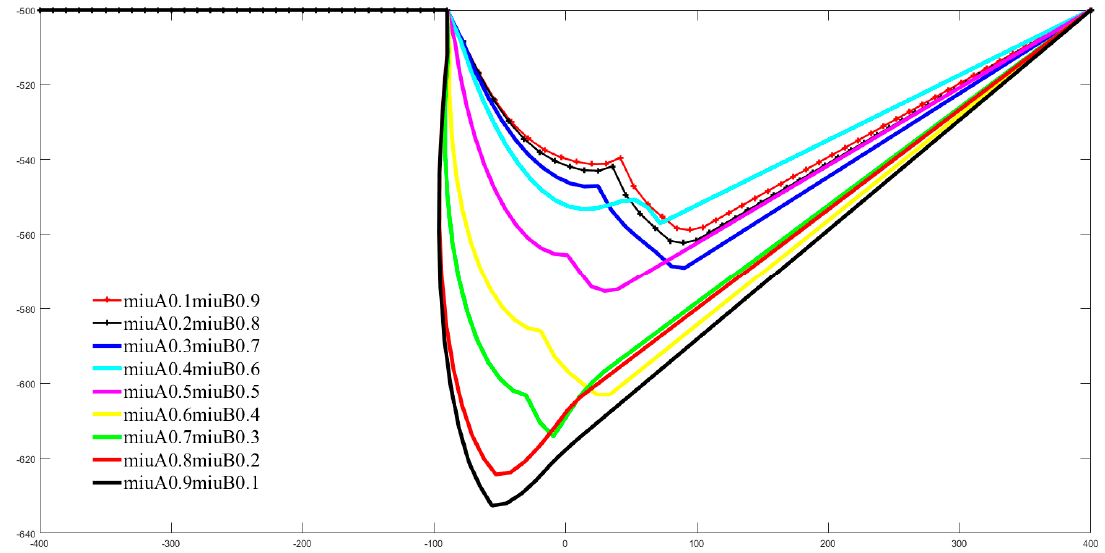
Figure 18. For Case 1 in Figure 13, the paths of the manipulator B EEF are simulated for different values of the positive circumventing weighting factors µ A and µ B .